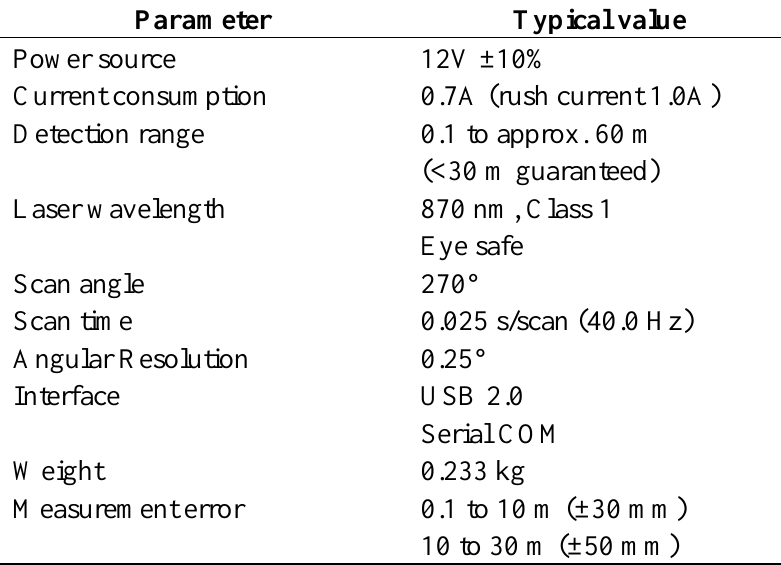
Table 1. Hokuyo UTM-30LX